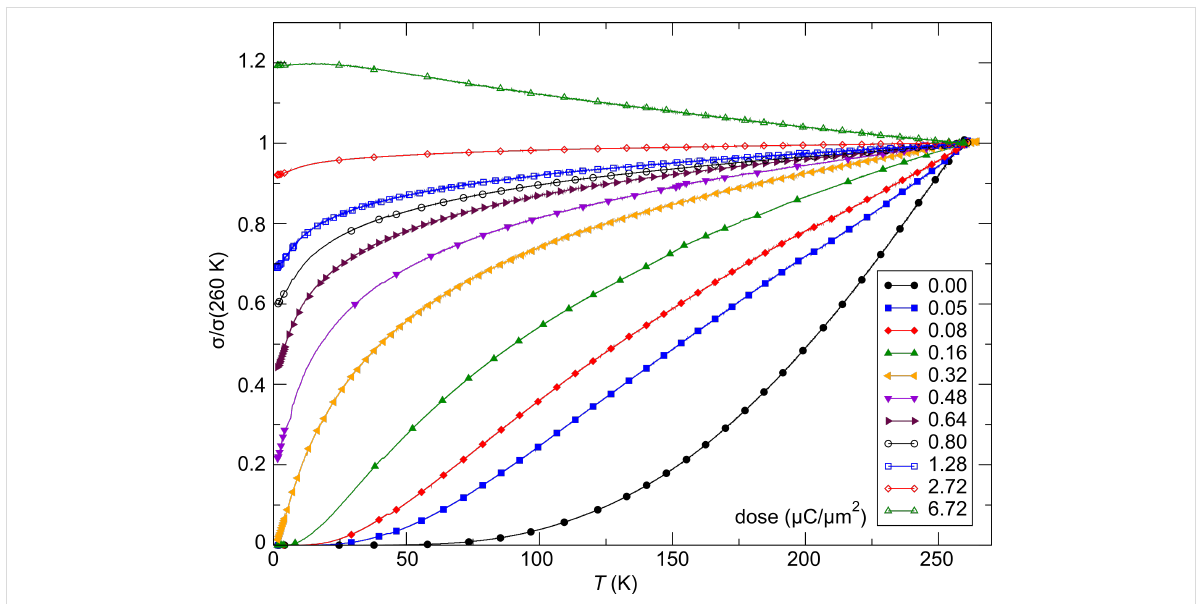
Figure 13: Temperature-dependent conductivity of Pt–C FEBID structures that have been exposed to different post-growth electron irradiation doses as indicated. See text for details. Adapted from